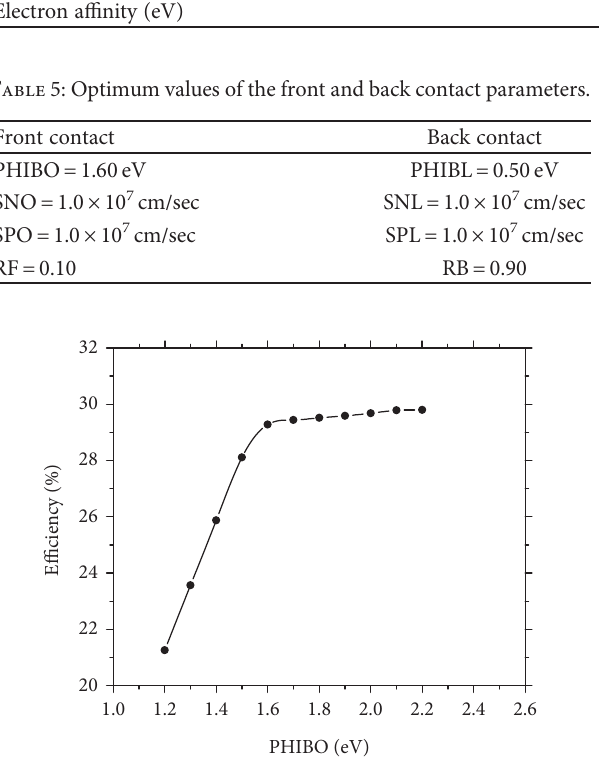
Figure 2: PHIBO versus e ffi ciency plot of the proposed solar cell ’ s front contact.